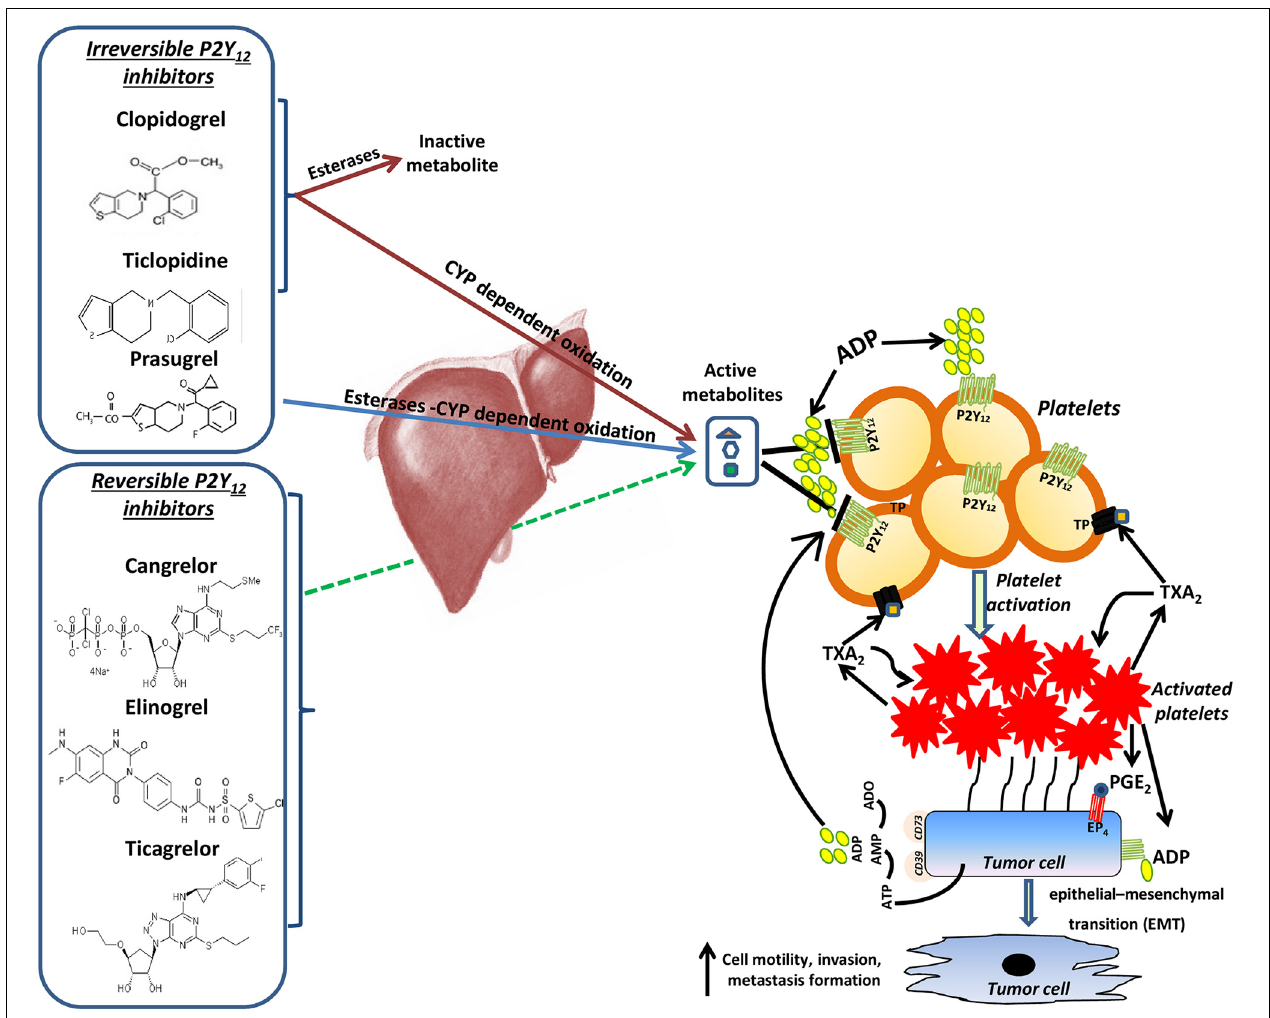
FIGURE 2 | The potential contribution of P2Y 12 receptor in cancer and metastasis. P2Y 12 receptor (R) antagonists include thienopyridines, such as ticlopidine, clopidogrel and prasugrel, that irreversibly inhibit P2Y 12 R upon metabolic conversion into active metabolites by the hepatic cytochrome P-450 system